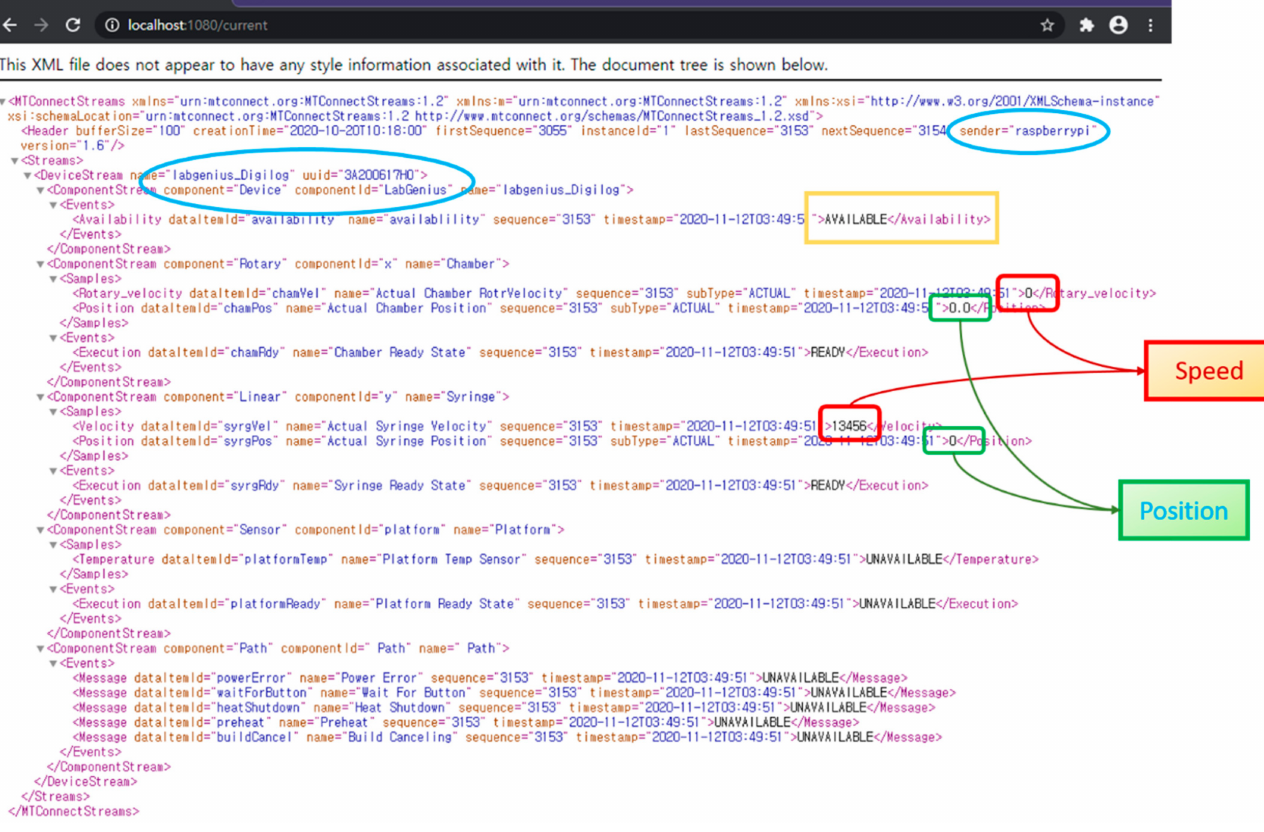
Figure 6. MTConnect Extensible Markup Language (XML) for “Current”